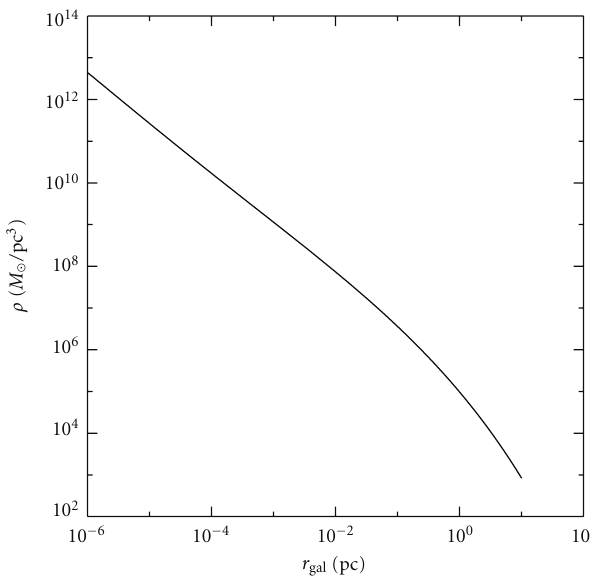
Figure 7: The stellar density profile that we adopt, based on the average density profile of Sch¨odel et al.